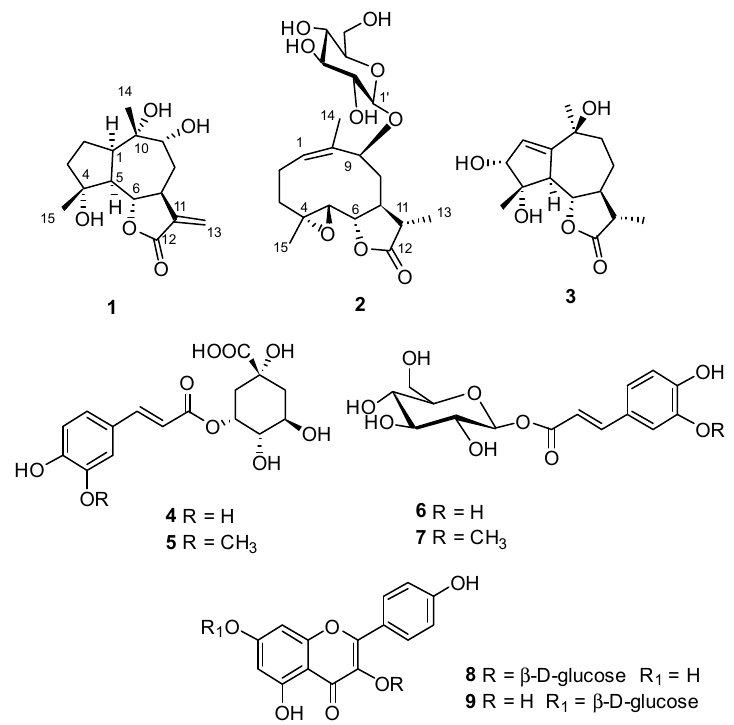
Figure 1. Chemical structures of metabolites isolated from Anvillea garcinia.